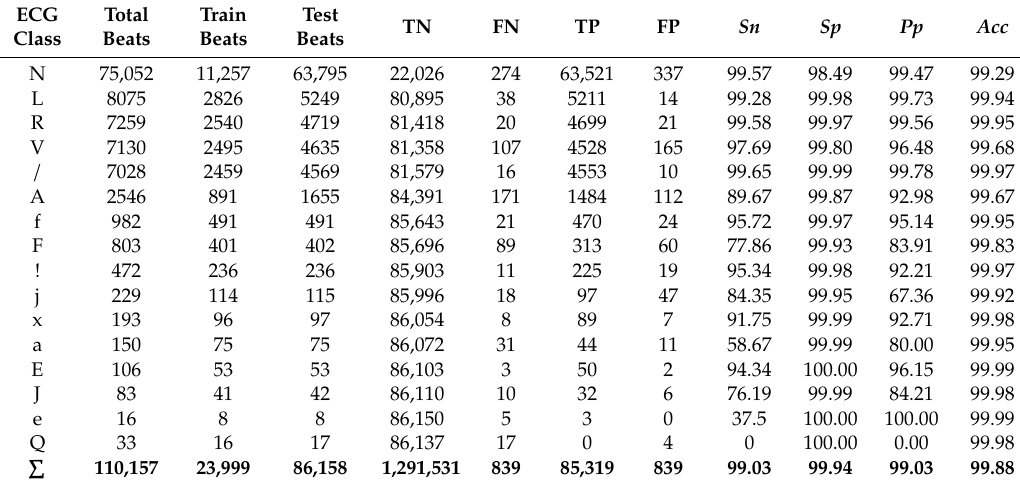
Performance evaluation for each class using [256 256 256] ensemble of depthwise separable